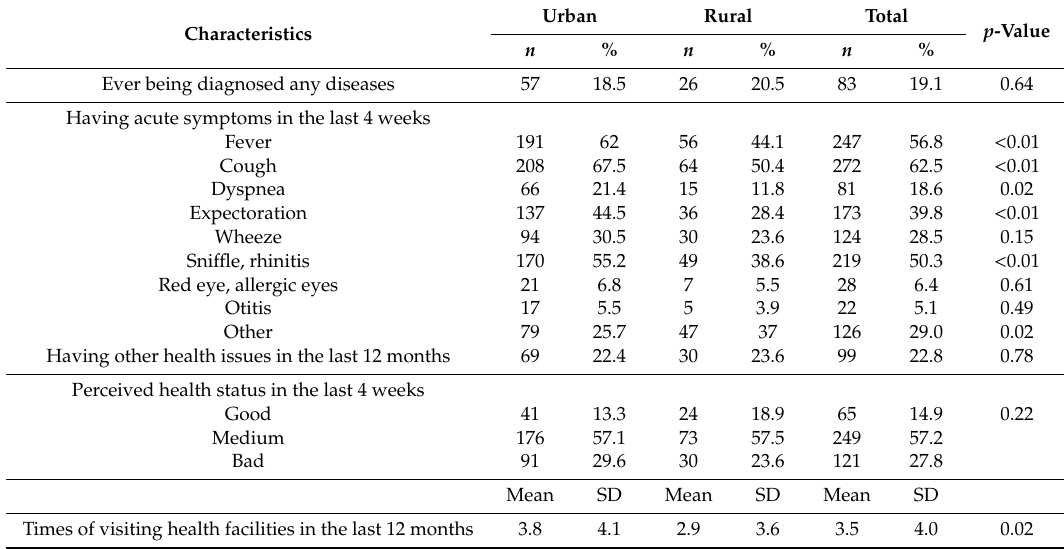
Table A1. Health status of participants prior to the